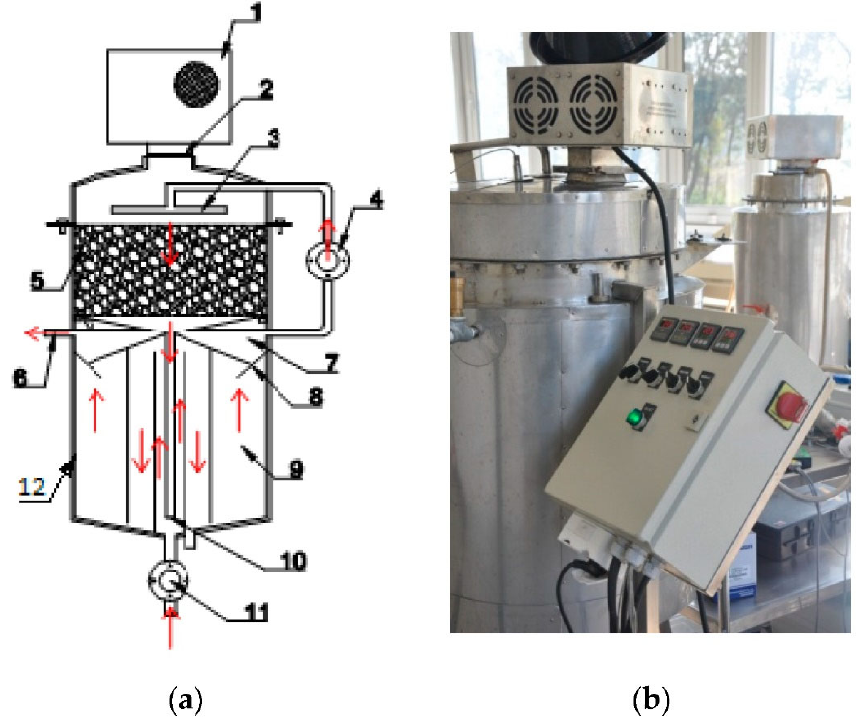
Figure 10. Diagram ( a ) and photograph ( b ) of the M-SHAR: 1—microwave generator, 2—microwave generator seal, 3—LDW supply, 4—circulation pump, 5—US of bed, 6—outlet, 7—LS; sludge separation area, 8—sludge collector, 9—LS; granular sludge area, 10—central hose, 11—LDW metering pump, 12—water jacket.